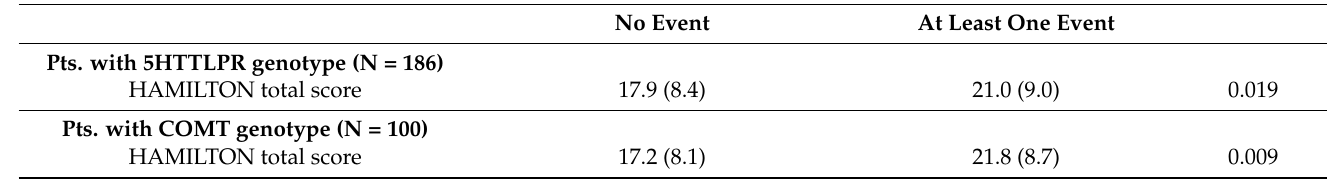
Table 3. Mean score differences in depression (HAMILTON) between patients who experienced at least one major stressful event in the 6 months preceding illness onset and patients who did